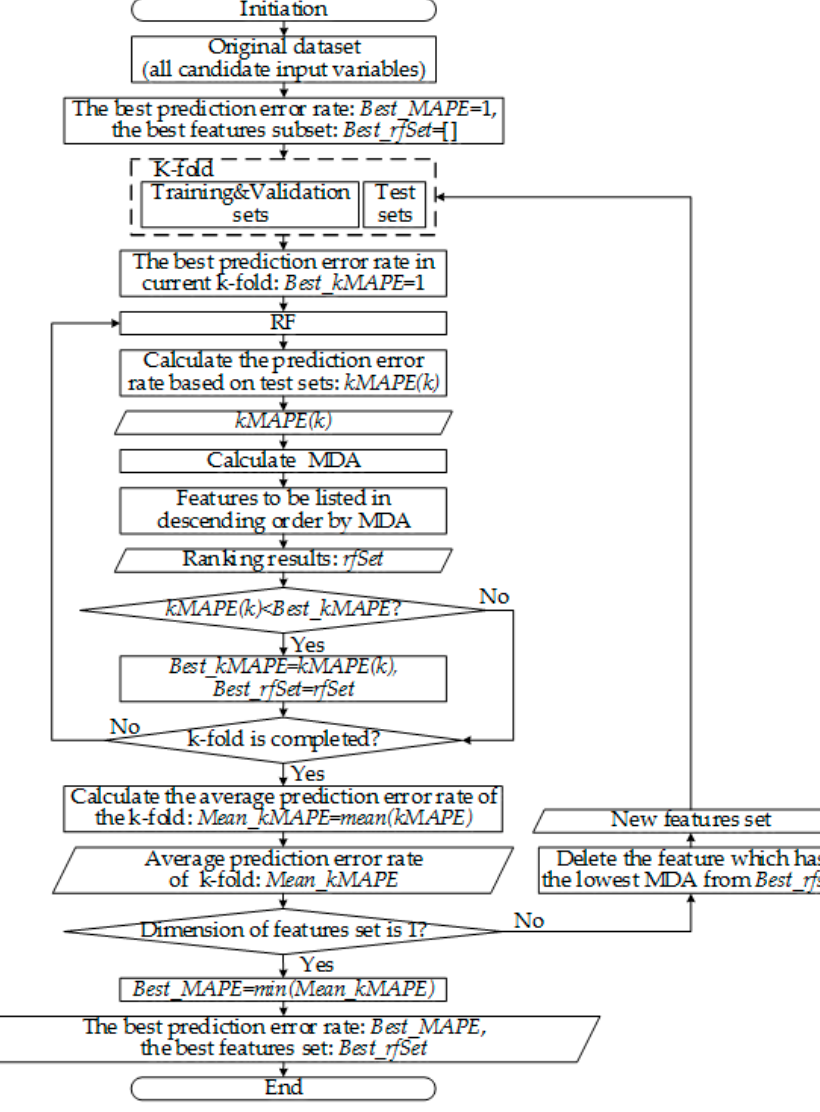
Figure 1. Flowchart for random forests (RF)-based input variable selection. MAPE: mean absolute percent error; MDA: mean decrease in accuracy; kMAPE: MAPE in the current k-fold process.